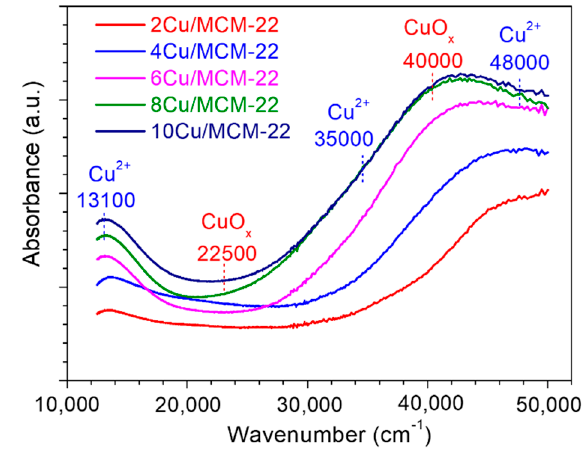
Figure 4. UV-vis spectra of x Cu/MCM-22 zeolites with different copper contents.